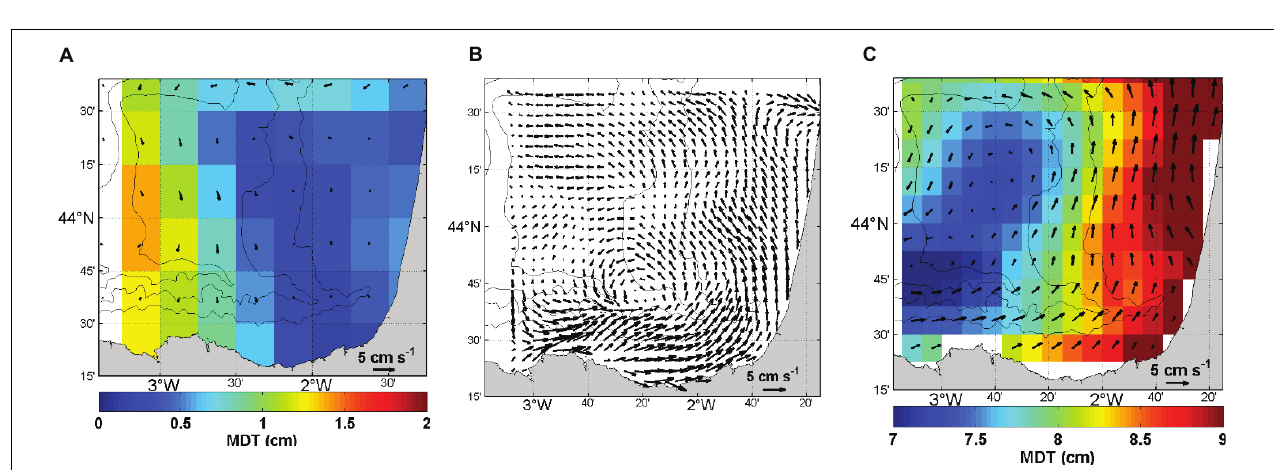
FIGURE 1 | (A) Location of the Bay of Biscay and of the study area (black square). (B) Zoom in the study area (SE-BoB). Footprint area of the HF radar system, location of its antennas (black points), and grid points of the total currents (gray points). The black line indicates the transect analyzed in Figure 11 .